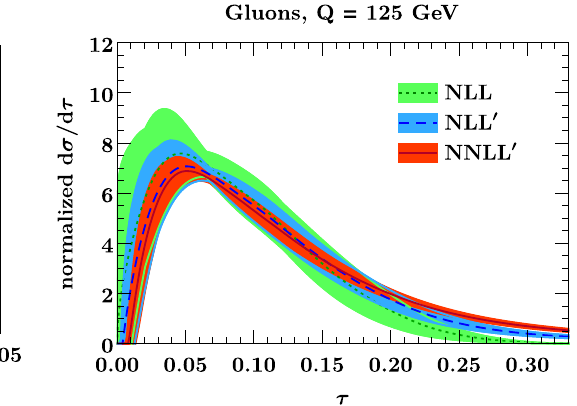
Fig. 2 The normalized thrust spectrum at NLL (green), NLL (cid:2) (blue), and NNLL (cid:2) (orange) for quarks (left panel) and gluons (right panel). Since the quark distribution on the left is peaked at small τ , we restrict